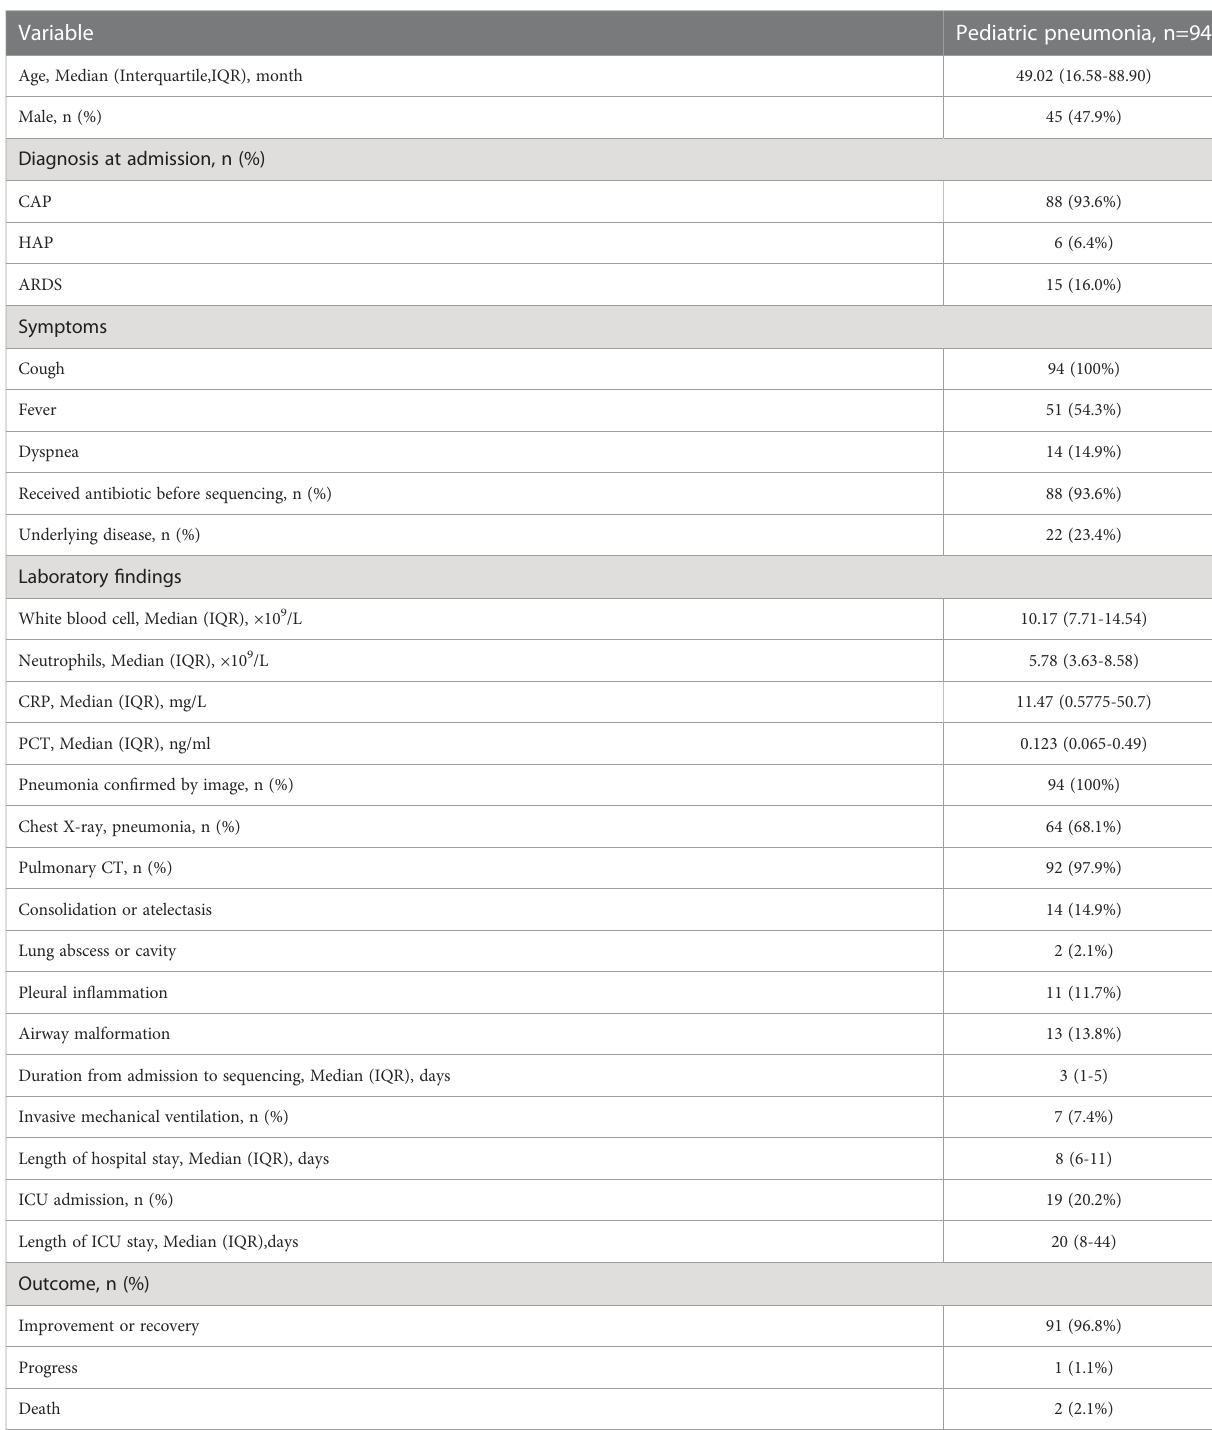
TABLE 2 Demographic and clinical characteristics of the 94 pediatric pneumonia